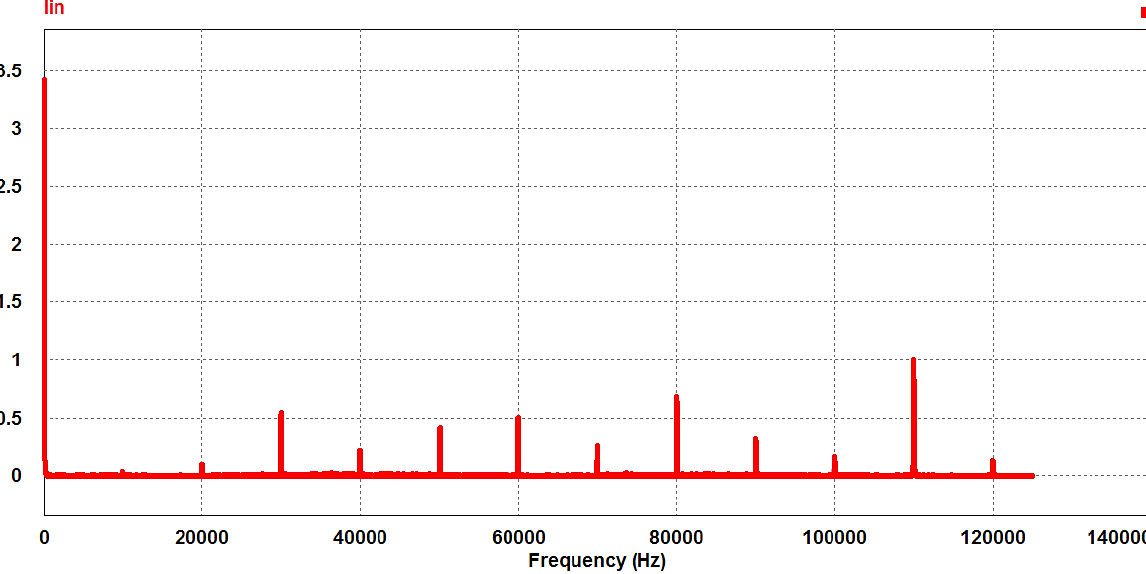
Figure 5. FFT analysis of input current of IH system without Boost PFC